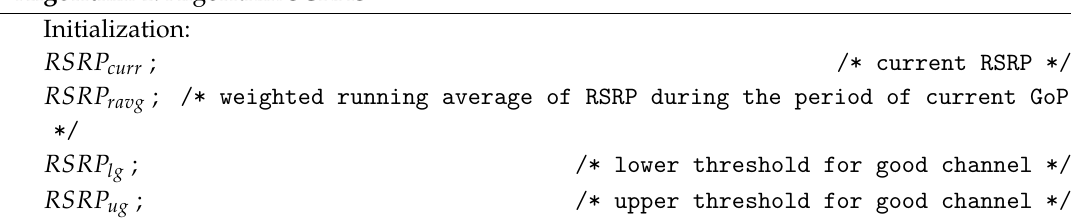
Algorithm 1: Algorithm